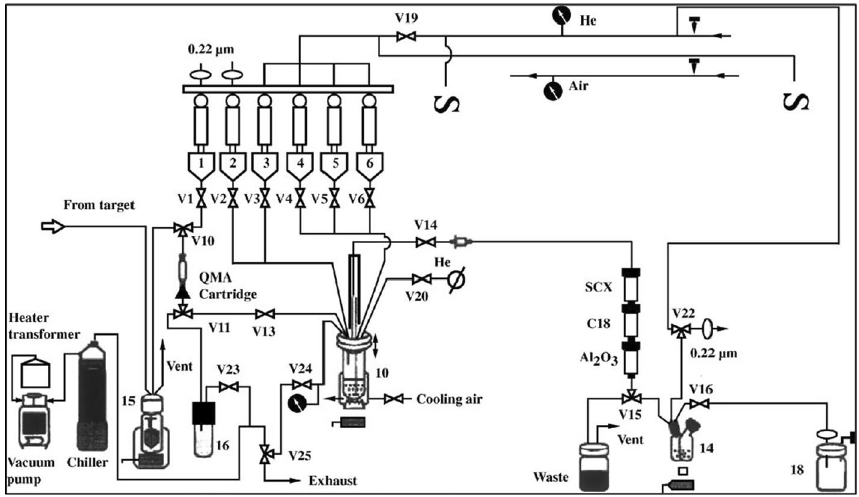
Fig. 1 Schematic diagram of automated synthesis of [ 18 F]FMISO using Sep-Pak based purification (Tang et al.